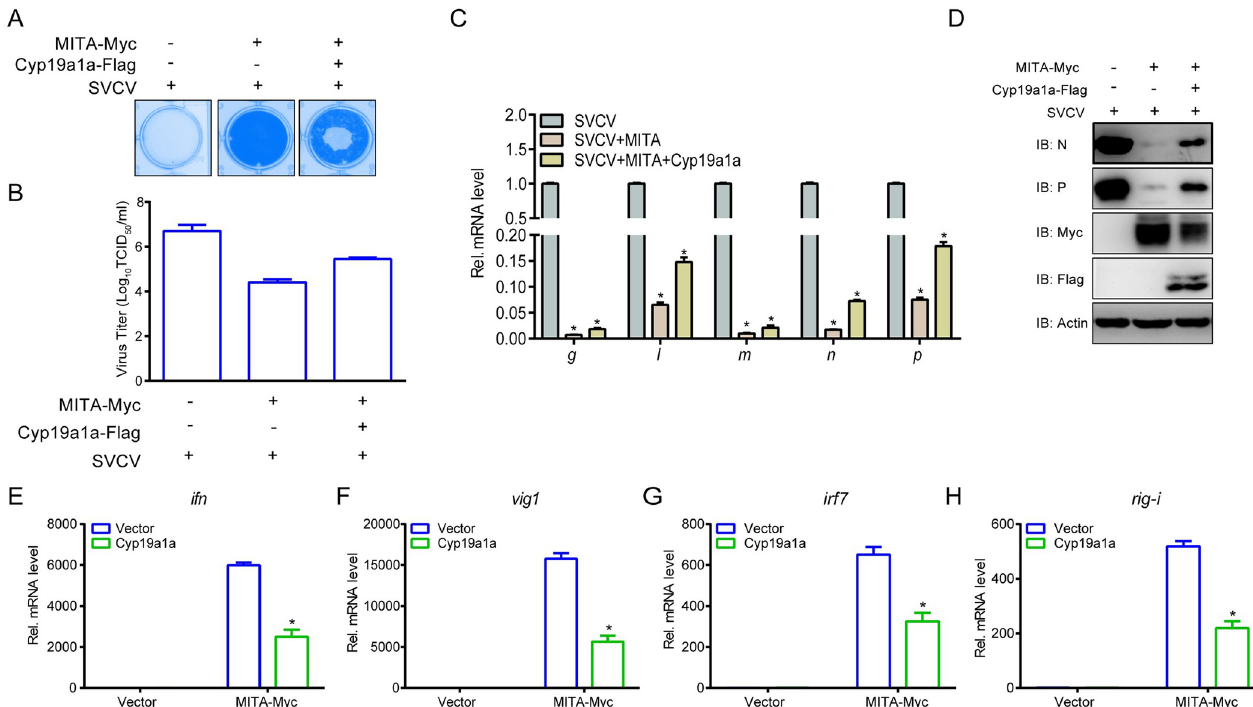
Fig 8. Cyp19a1a blocks MITA-mediated cellular antiviral response. (A and B) EPC cells were transfected with 0.25 μ g MITA-Myc and 0.25 μ g Cyp19a1a- Flag or empty vector. At 24 h post-transfection, cells were infected with SVCV (MOI = 0.001) for 48 h. Then, cells were fixed with 4% PFA and stained with 1% crystal violet (A). Culture supernatants from the cells infected with SVCV were collected, and the viral titer was measured according to the method of Reed and Muench (B). (C) EPC cells were transfected with 1.5 μ g Cyp19a1a-Flag or empty vector together with 1.5 μ g MITA-Myc or empty vector. At 24 h post- transfection, cells were infected with SVCV (MOI = 1). After 24 h-infection, total RNAs were extracted to examine the mRNA levels of cellular g , l , m , n , and p . (D) The same samples were prepared similarly as described above for panel C. The lysates were detected by IB with anti-N, anti-P, anti-Myc, anti-Flag, and anti- β -actin Abs, respectively. (E-H) Overexpression of Cyp19a1a suppresses the expression of epc ifn (E) , epc vig1 (F), epc irf7 (G), and epc rig-i (H) induced by MITA. EPC cells were transfected with 1.5 μ g Cyp19a1a-Flag or empty vector together with 1.5 μ g MITA-Myc or empty vector. At 24 h after transfection, total RNAs were extracted for further qPCR assays. The relative transcriptional levels were normalized to the transcriptional level of the β -actin gene and were represented as fold induction relative to the transcriptional level in the control cells, which was set to 1. Data were expressed as mean ± SEM, n = 3. Asterisks indicate significant differences from control values ( � , p <